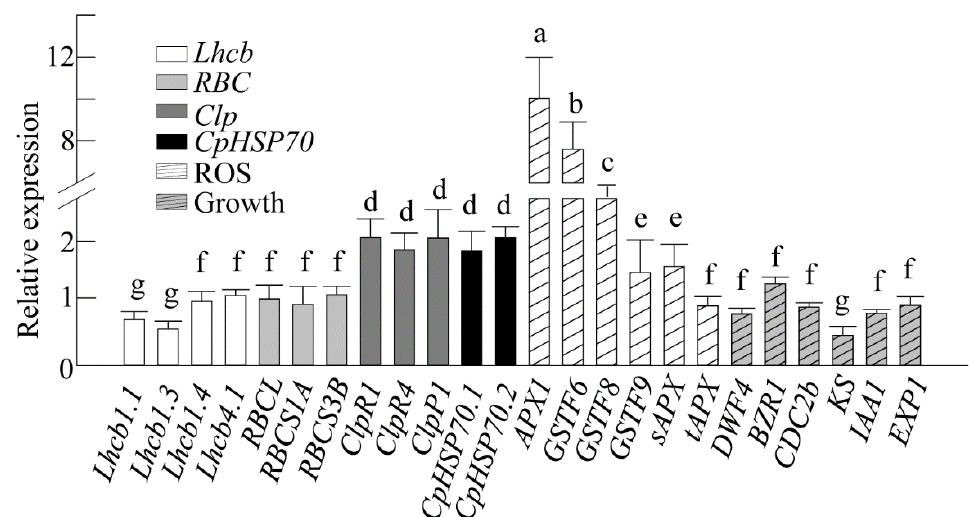
Figure 6. Effects of exogenous melatonin treatment on various genes related to photosynthesis, protein quality control, ROS defense, and growth. WT Arabidopsis (four weeks old) leaves were infiltrated with 1 μM melatonin at ZT0 and transferred to dim - light conditions (7 μmol m -2 s -1 ) to rule out potential light induction of various target genes. The samples were harvested at ZT6 for total RNA isolation. The genes evaluated were Lhcb1.1 (At1g29910), Lhcb1.3 (At1g29930), Lhcb1.4 (At2g34430), Lhcb4.1 (At5g01530), RBCL (AtCg00490), RBCS1A (At1g67090), RBCS3B (At5g38410), ClpR1 (At1g49970), ClpR4 (At4g17040), ClpP1 (AtCg00670), CpHSP70.1 (At4g24280), CpHSP70.2 (At5g49910), APX1 (At1g07890), GSTF6 ( GST1 ; At1g02930), GSTF8 (At2g47730), GSTF9 (At2g30860), sAPX (At4g08390), tAPX (At1g77490), DWF4 (At3g50660), BZR1 (At1g75080), CDC2b (At3g54180), KS (At1g79460), IAA1 (At4g14560), and EXP1 (At1g69530). The relative fold expression values are normalized to EF1 α expression, and the expression level after each mock treatment (2 mM MgCl 2 ) was set at a relative level of 1. Different letters indicate significant differences (Tukey’s post hoc HSD test; p < 0.05).